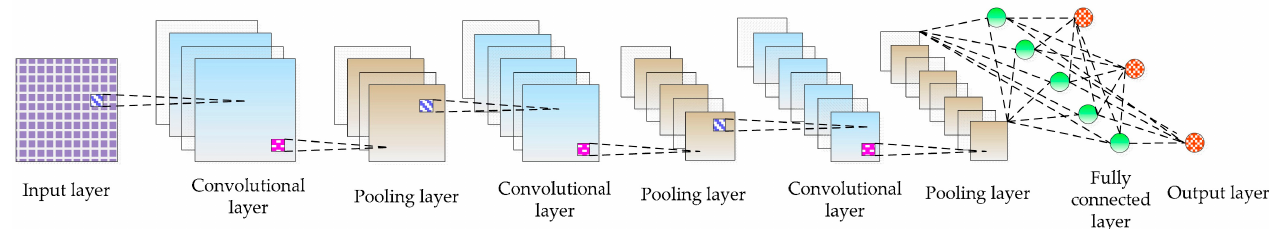
Figure 4. CNN’s fundamental structure.